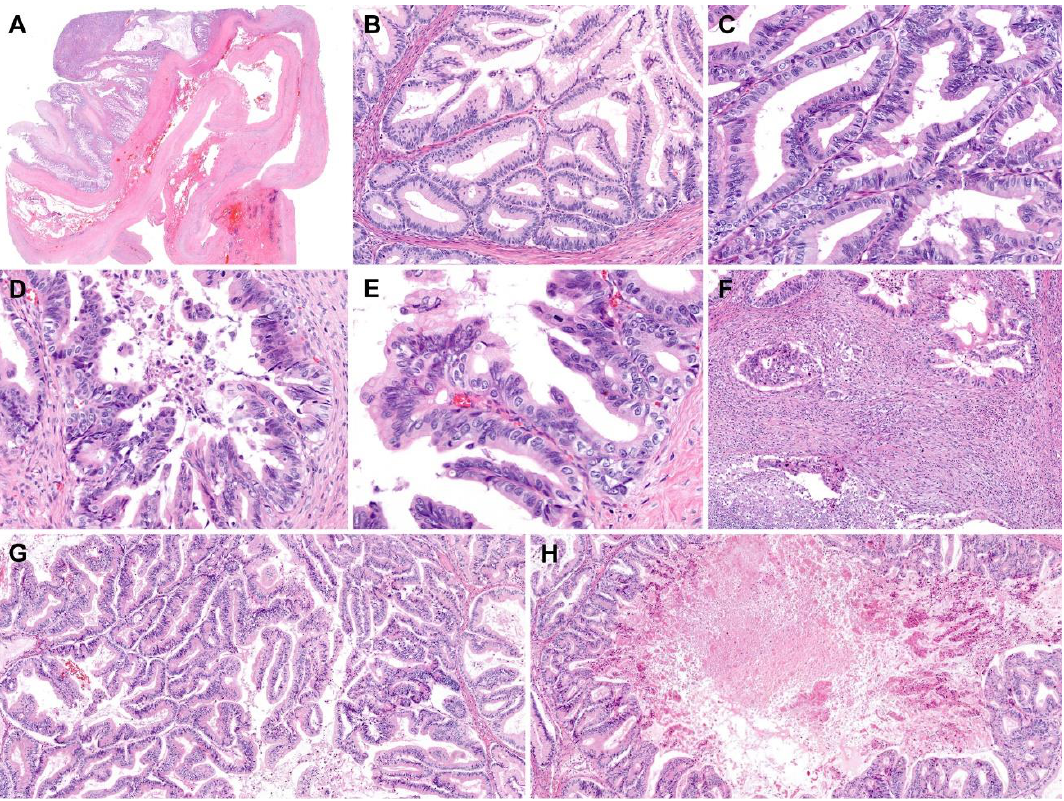
Figure 2. Histological features of retroperitoneal mucinous carcinoma. ( A ) The thick fibrous wall showed mural hemorrhage. ( B ) Areas showing glandular proliferation were characterized by nuclear stratification and low-to-intermediate-grade nuclear atypia without stromal invasion, compatible with a mucinous borderline tumor. ( C – E ) In several foci, ( C ) high-grade nuclear atypia, ( D ) a micropapillary pattern, a loss of polarity, and ( E ) intraluminal papillary projections were noted. ( F ) Irregularly shaped cellular clusters and cribriform glands infiltrated the stroma, indicating microinvasion. There were associated stromal inflammatory infiltrates and desmoplastic reactions. ( G , H ) In addition to mucinous borderline tumors and microinvasive mucinous carcinomas, areas characterized by confluent glandular proliferation without intervening stroma were present, compatible with mucinous carcinomas with an expansile invasive pattern. A large, proliferating gland exhibited a cribriform architecture. Its